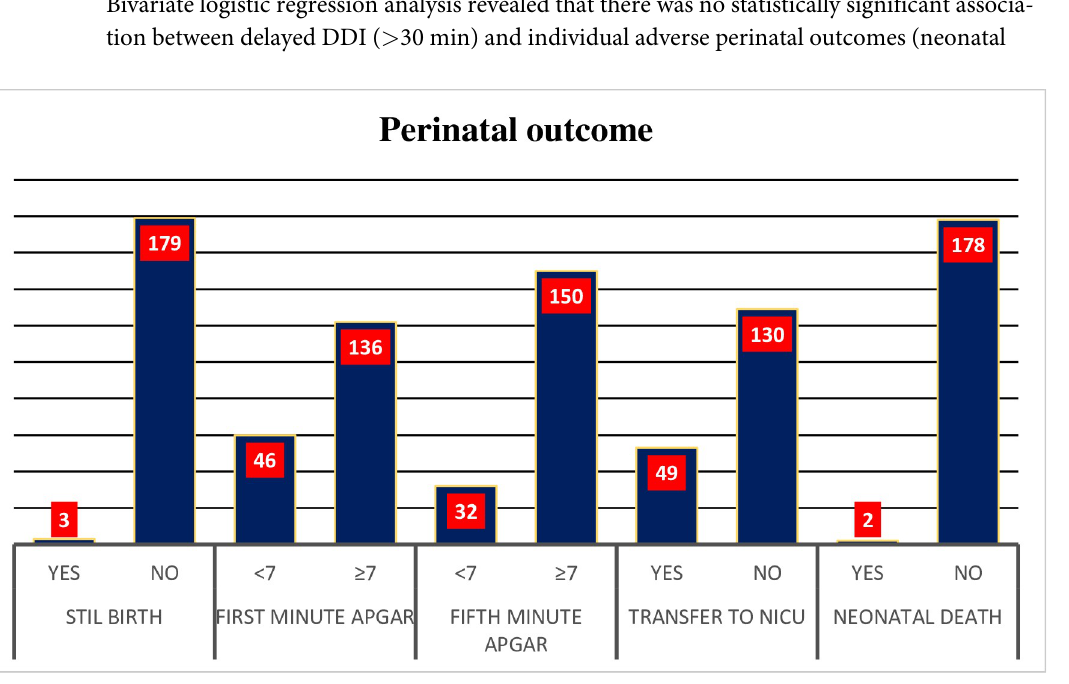
Fig 1. Shows perinatal outcomes of emergency caesarean section in Bahir Dar city public Hospitals Northwest Ethiopia, 2020 (n =